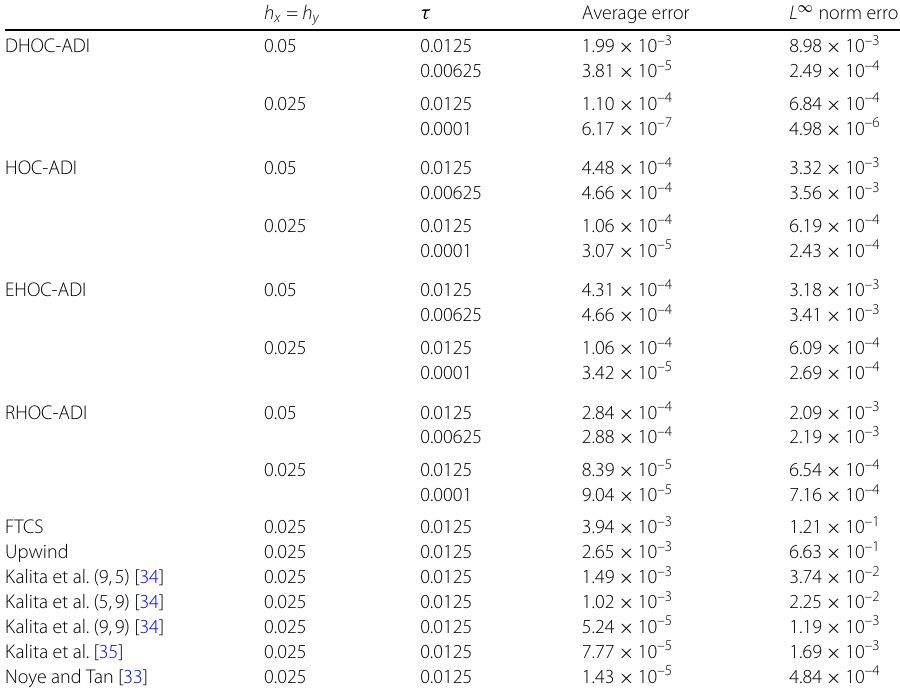
Table 6 Comparison errors at T = 1.25 with different h x , h y , and